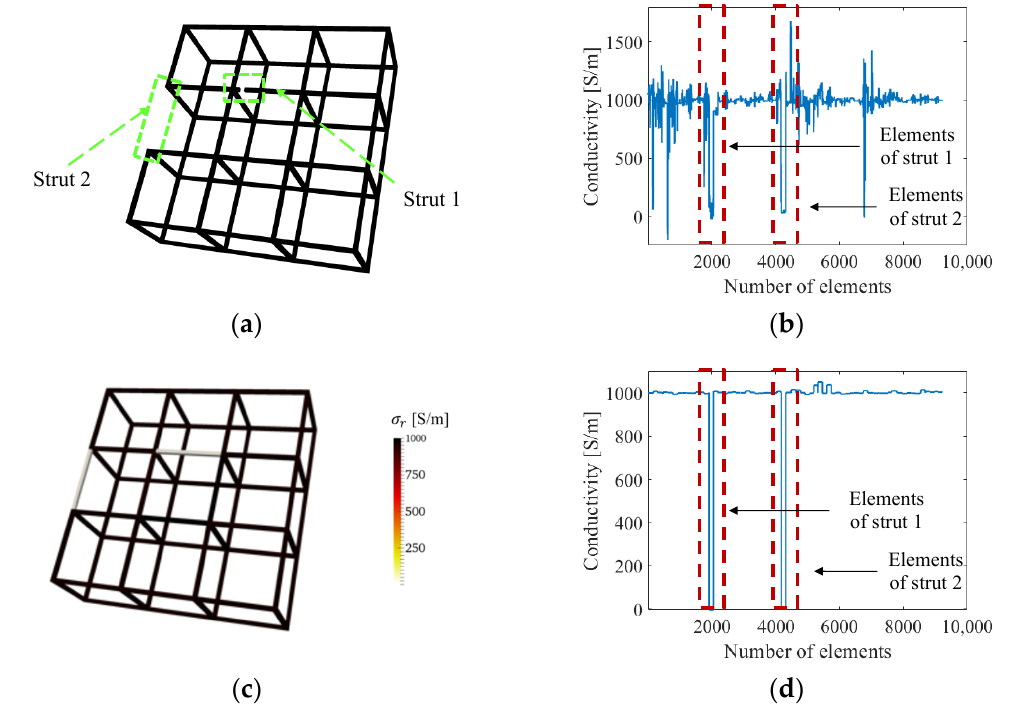
Figure 8. ( a ) A lattice structure with two damaged struts. ( b ) The reconstructed conductivity values of each element when solved without the normalized sensitivity map. ( c ) The reconstructed 3D conductivity distribution and ( d ) the conductivity values for each element, when solved using the normalized sensitivity map. Table 3. Errors quantification and comparison of multi-defect reconstructions in